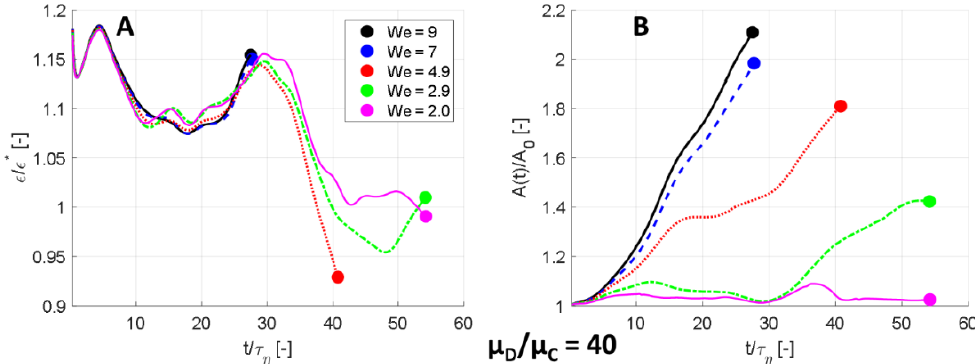
Figure 12. Suppression of turbulence for a high viscosity drop ( µ D / µ C = 40). ( A ) Dissipation rate of TKE, ε , normalized to the one-phase flow time-averaged value, ε * , as a function of time, t . ( B ) Total interfacial area, A , normalized with its initial value, A 0 .